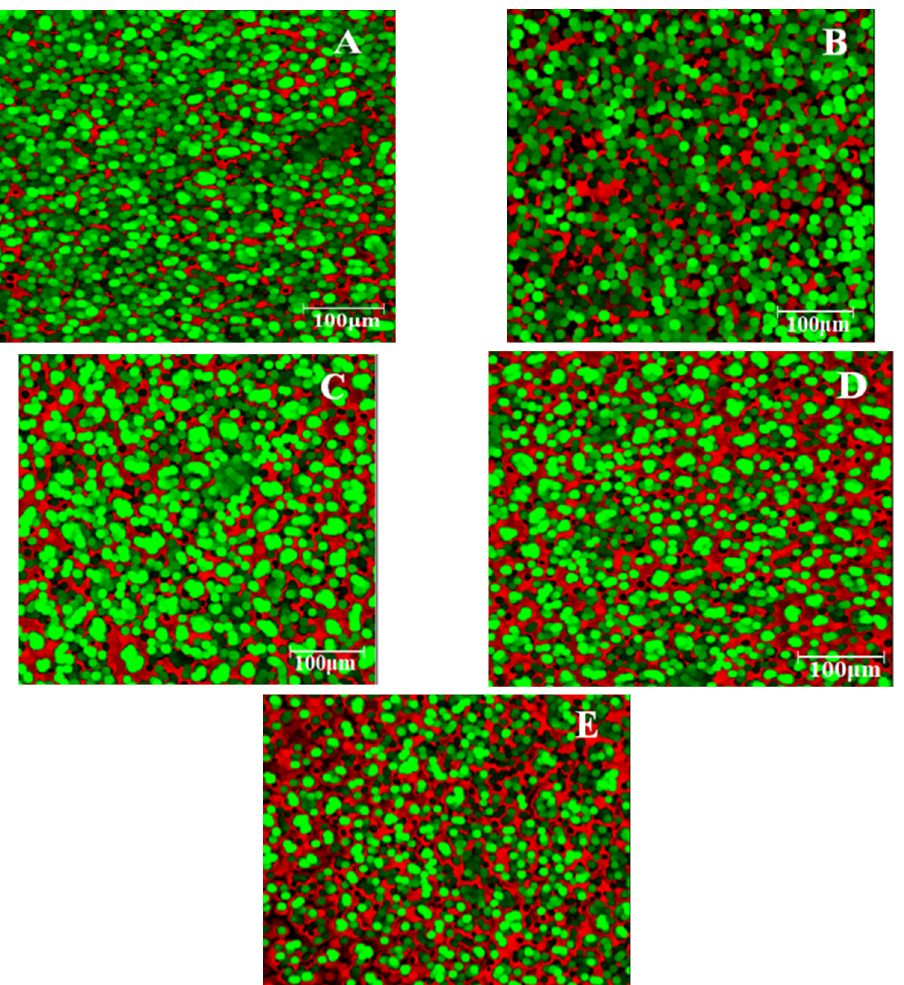
Figure 3. Microstructure taken by EFLM of wheat dough with germinated chickpea flour (GCF) at different levels: 0% ( a ), 5% ( b ), 10% ( c ), 15% ( d ), 20% ( e ). Red — protein; green — starch granules.